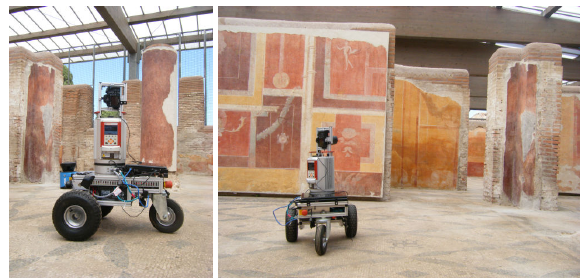
Figure 5: Irma3D at the garden house in Ostia Antica.